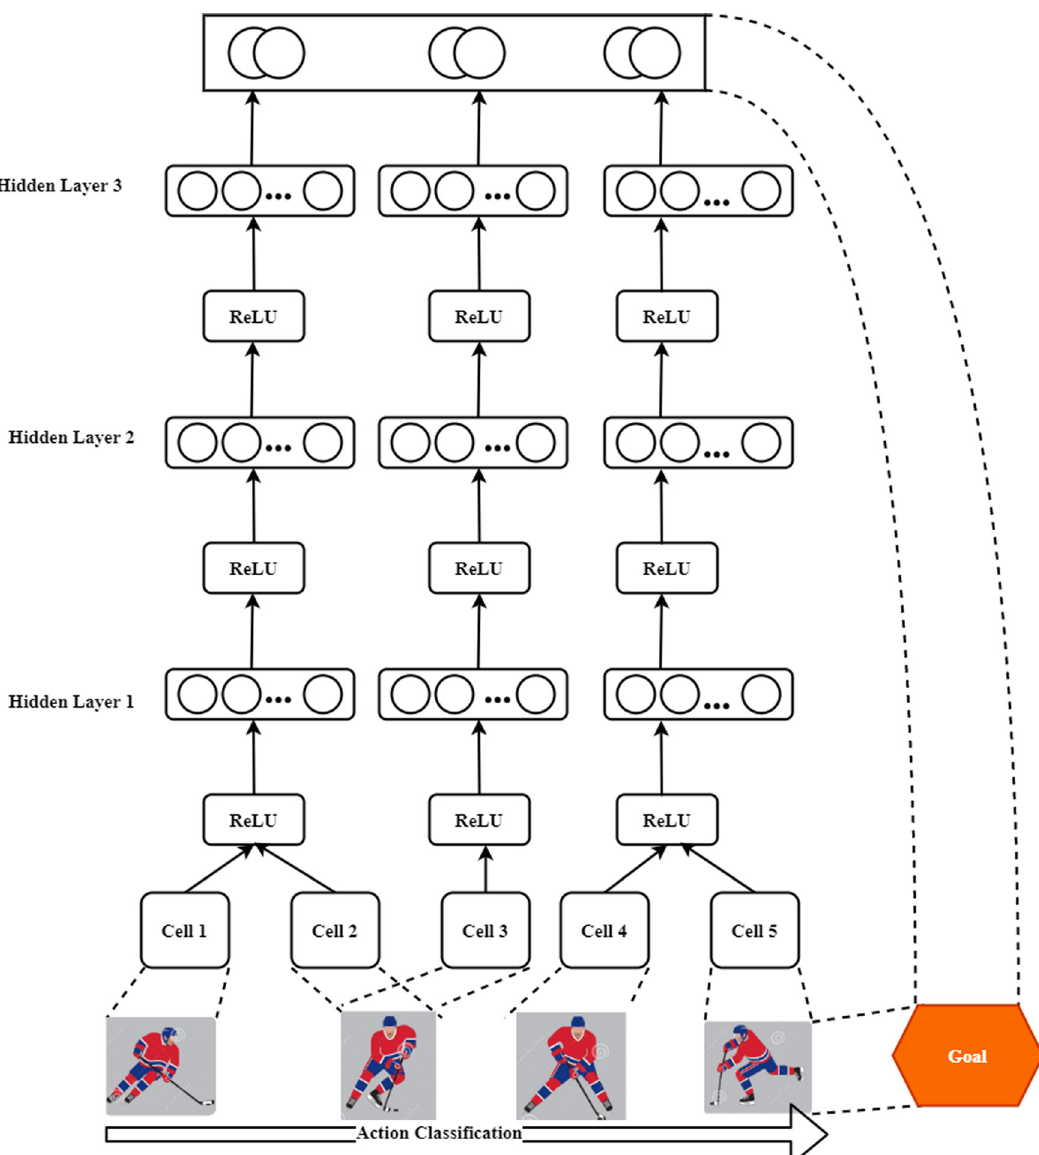
Five CONV layers have been used in the suggested model with ReLU Layers and the response regular - ization layer to extract the full feature map from the input frame to train the data set with high accuracy. Figure 5 shows the action classi fi cation. Our model is a fi ve - layer network with three hidden layers. Every hidden layer consists of 1,000 nodes, which use a ReLU activation function. The initial hidden layer and the remaining layer are fully connected. Temporal - variance learning looks ahead to the